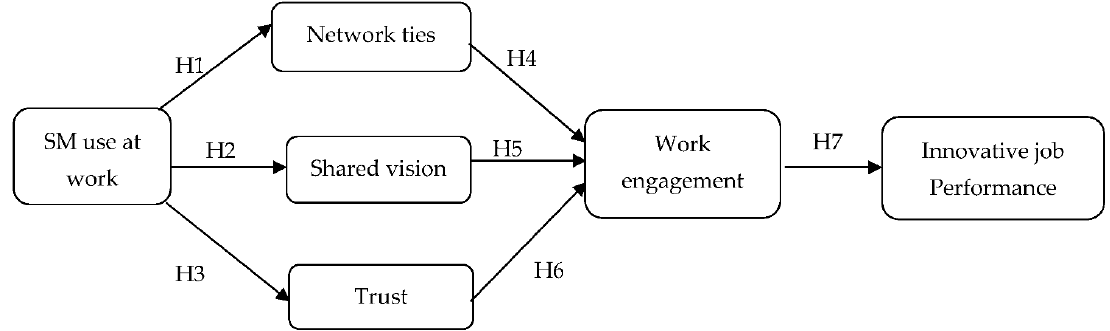
Figure 1. Research